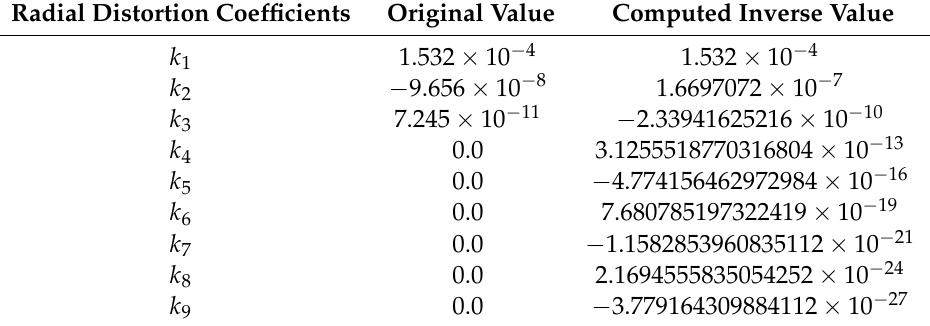
Table 1. Radial distortion calibration in Column two. Column three, inverse of radial distortion with coefficient from k 1 ... k 9